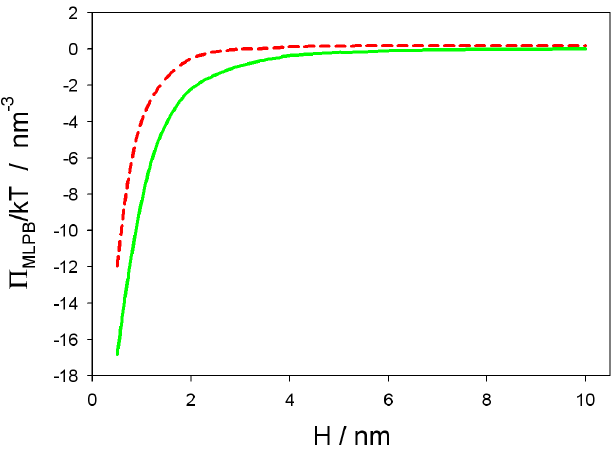
Figure 3. Osmotic pressure between between a negatively and positively surface (see Figure 2) as a function of the distance between both surfaces ( H ), calculated within the modified Langevin-Poisson-Boltzmann (MLPB) model for two values of the bulk salt =N = 0 : 1 mol = L (dashed line) and n =N = 0 : 01 mol = L (full line). Other concentration, n 0 A 0 A = (cid:0) 0 : 3 As = m 2 , (cid:27) = 0 : 3 As = m 2 , T = 298 K , concentration of model parameters are : (cid:27) 1 2 =N = 55 mol = L , and dipole moment of water, p = 3 : 1 Debye , where N water, n 0 w A 0 Avogadro